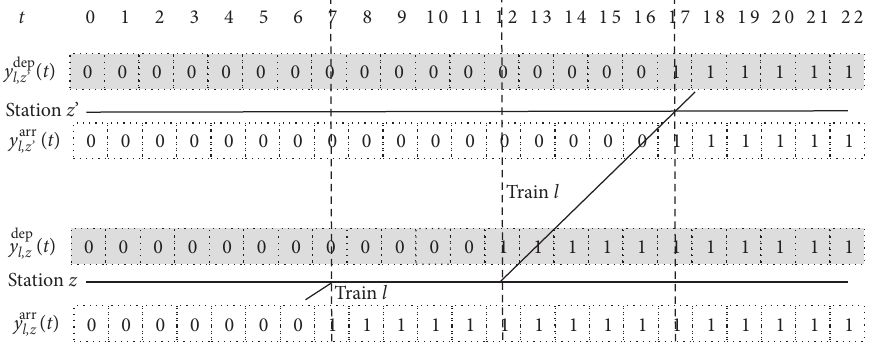
Figure 2: An illustration to accumulative state variables.